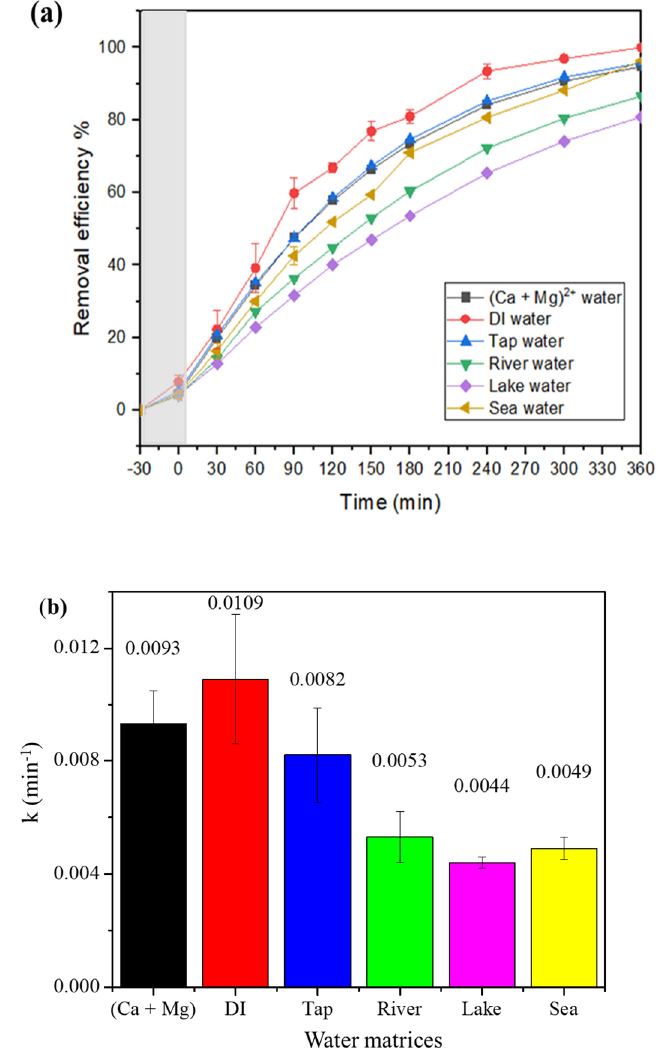
Figure 4. Degradation of CBZ in different waters: ( a ) Removal efficiency; ( b ) kinetic degradation. (DI = ultrapure water.)